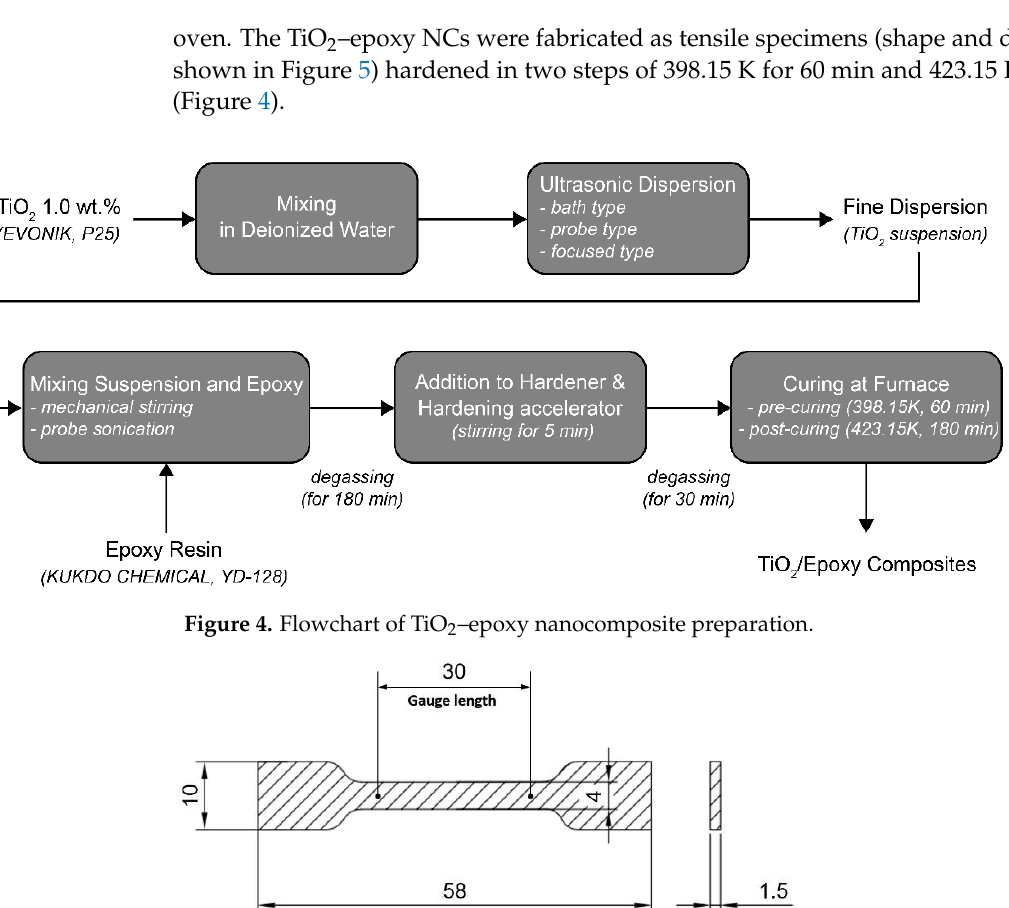
Figure 5. Dimensions for the tensile test